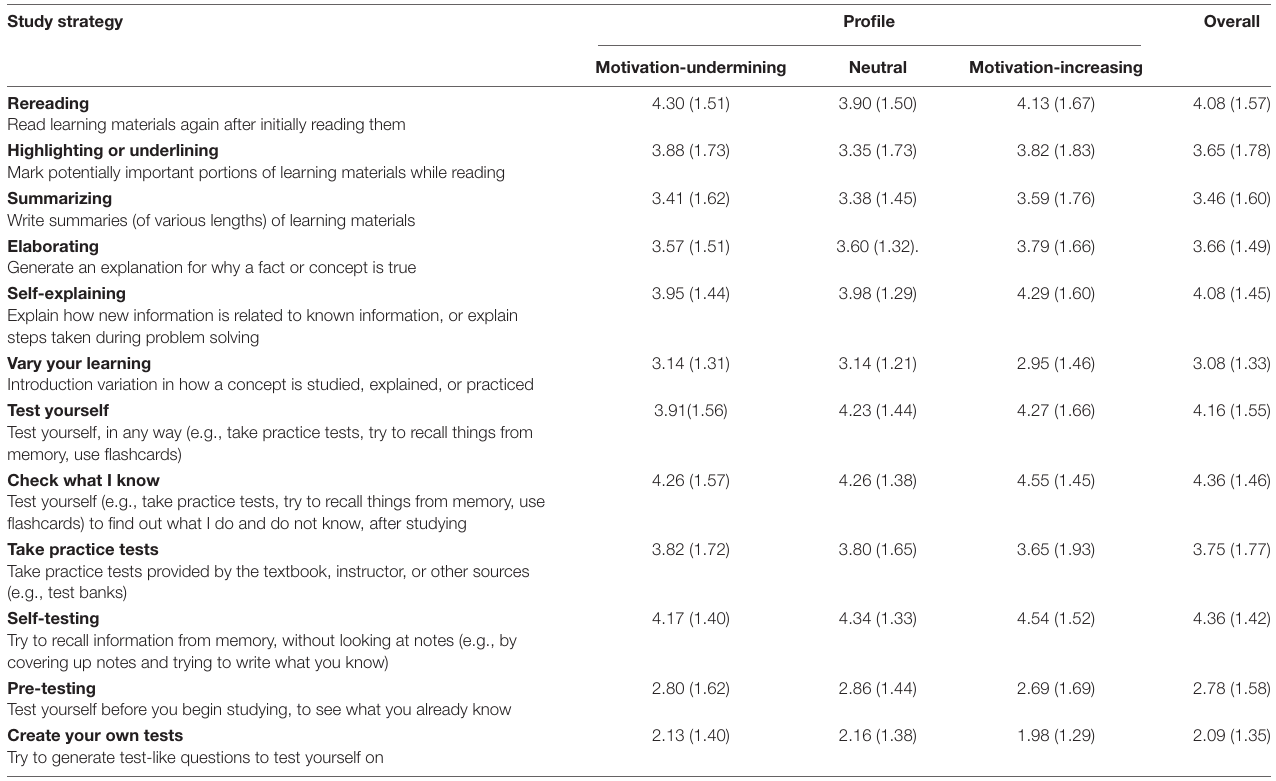
TABLE 4 | Mean and standard deviation for use of each study strategy by implicit belief profiles. Study